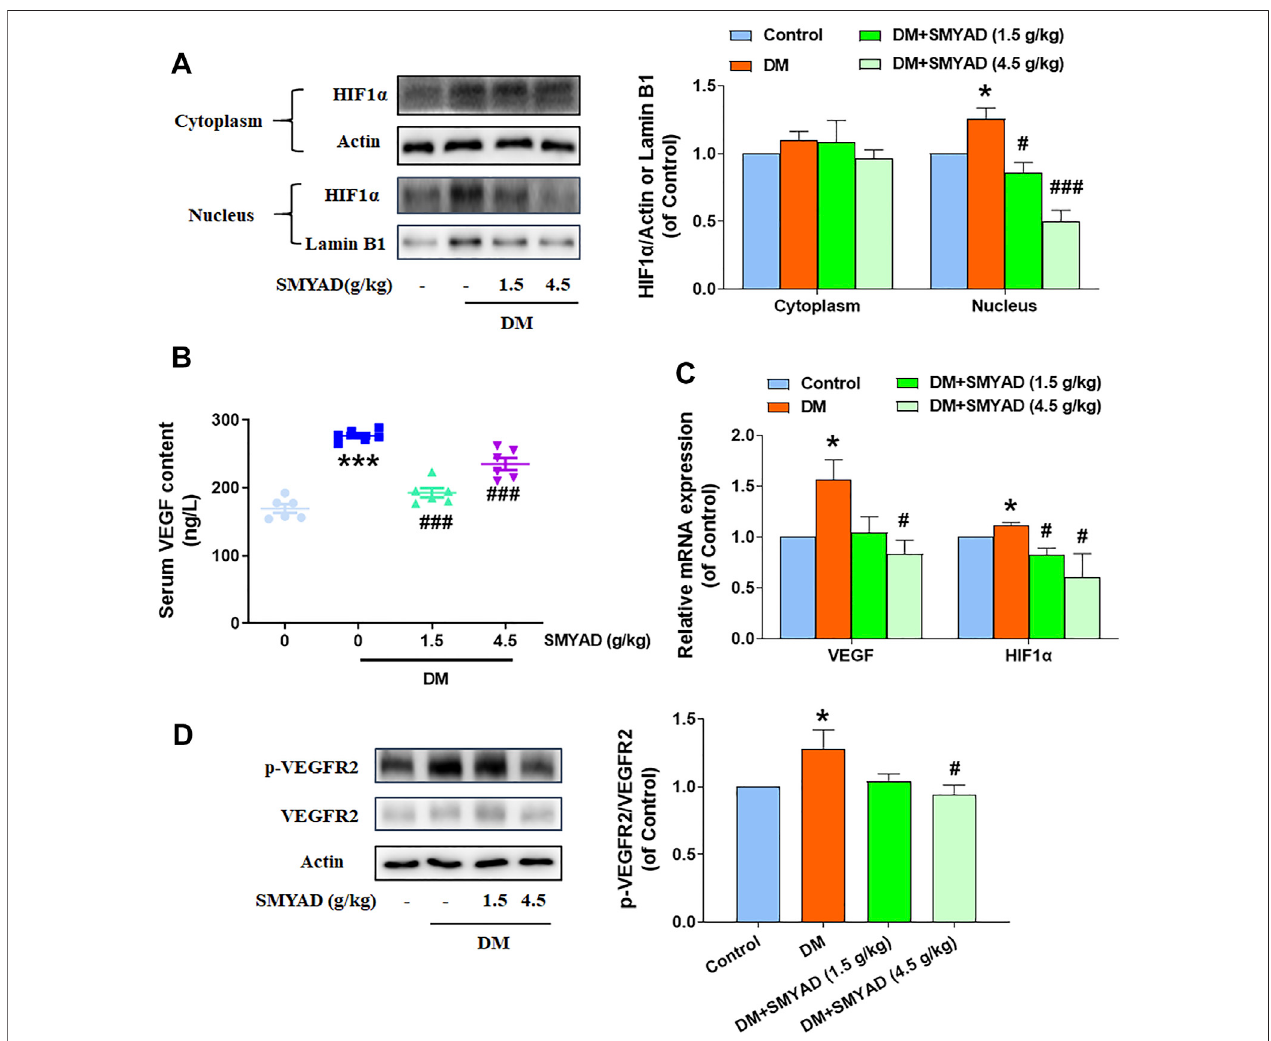
FIGURE 6 | SMYAD inhibited the HIF1 α -VEGF/VEGFR2 signal pathway in vivo . (A) SMYAD reduced nuclear accumulation of HIF1 α in retinas. The quantitative result is shown at right (n (cid:2) 3). (B) Serum VEGF content (n (cid:2) 6). (C) HIF1 α and VEGF mRNA expression in retinas (n (cid:2) 3). (D) SMYAD decreased the elevated phosphorylation of VEGFR2. The quantitative result is shown at right (n (cid:2) 3). Data (cid:2) mean ± SEM. * p < 0.05, *** p < 0.001 vs. control; # p < 0.05, ### p < 0.001 vs. DM.